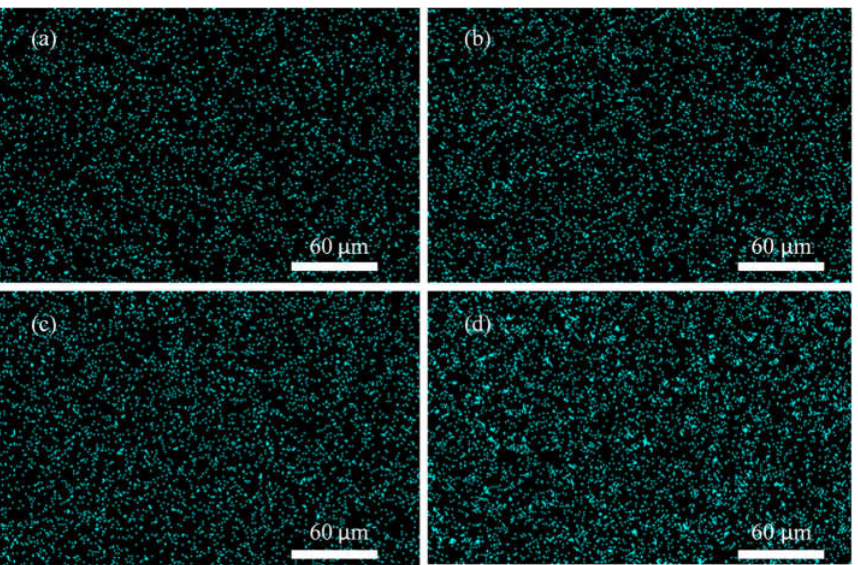
Figure 3. Mapping of silicon in PES/unmodified silica MMMs ( a ) S7 ( b ) S8 ( c ) S9 and ( d ) S10.